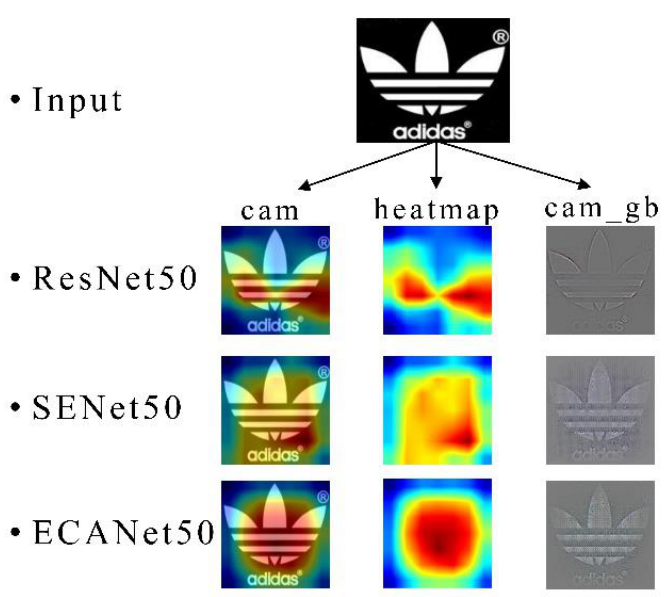
Figure 7. Visualization effect of Convolutional Neural Network (CNN) on trademark image.